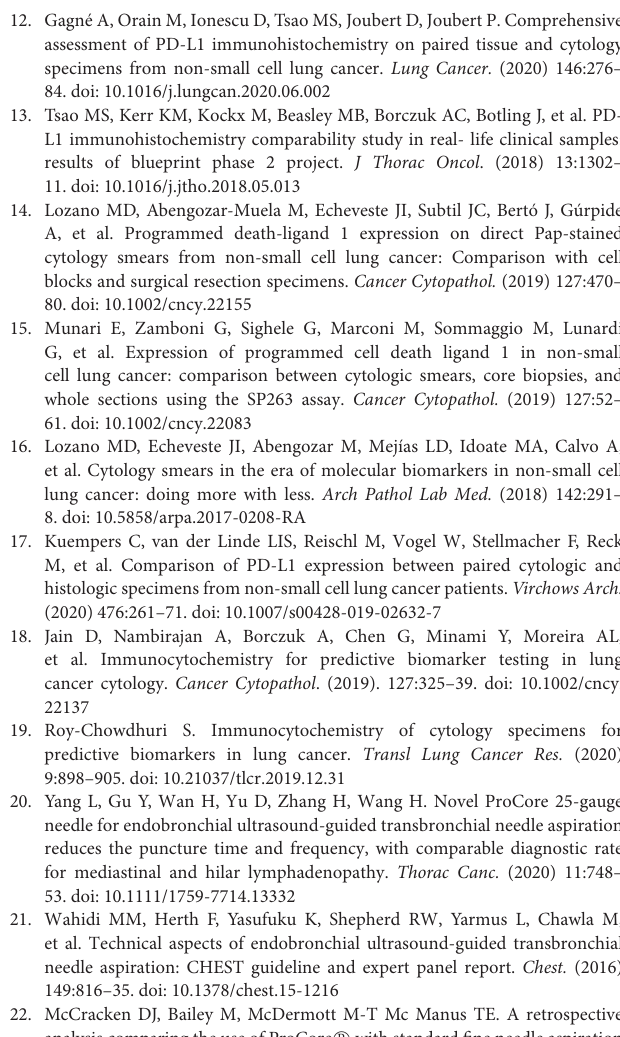
ML and JE: figure design. All authors validation, investigation, and